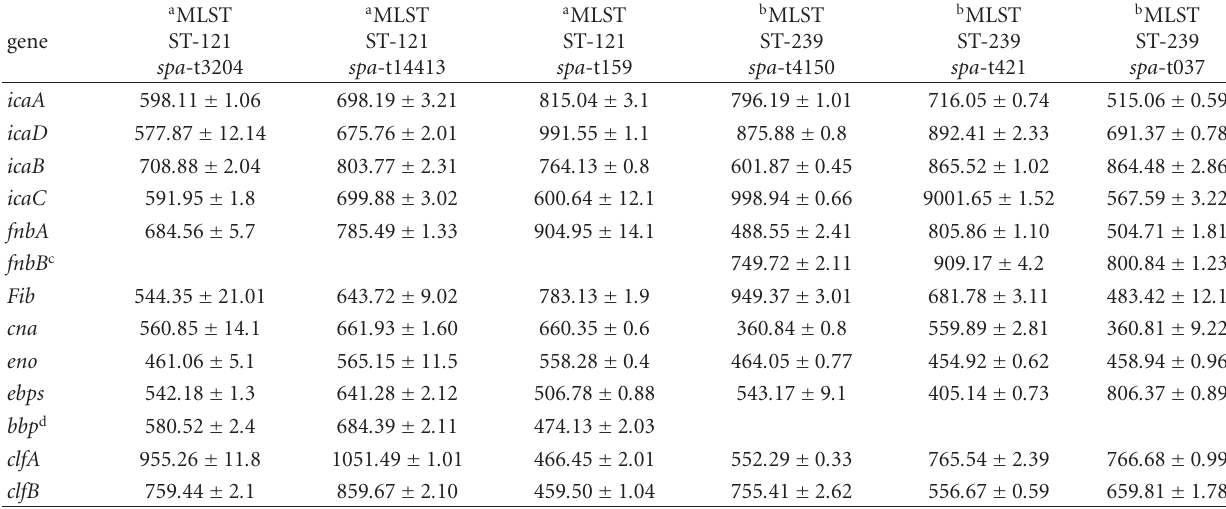
Table 4: Comparison of gene expression levels among 6 di ff erent clones of spa types by measuring the band intensities of RT-PCR amplicons using nanodrop spectrophotometer (ng/ µ L).